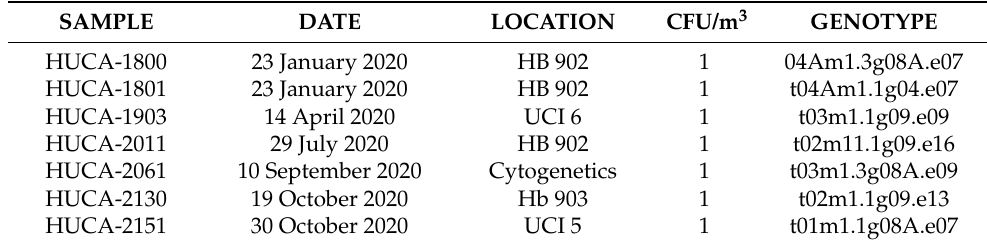
Table 2. A. fumigatus TRESPERg genotypes of isolates from environmental